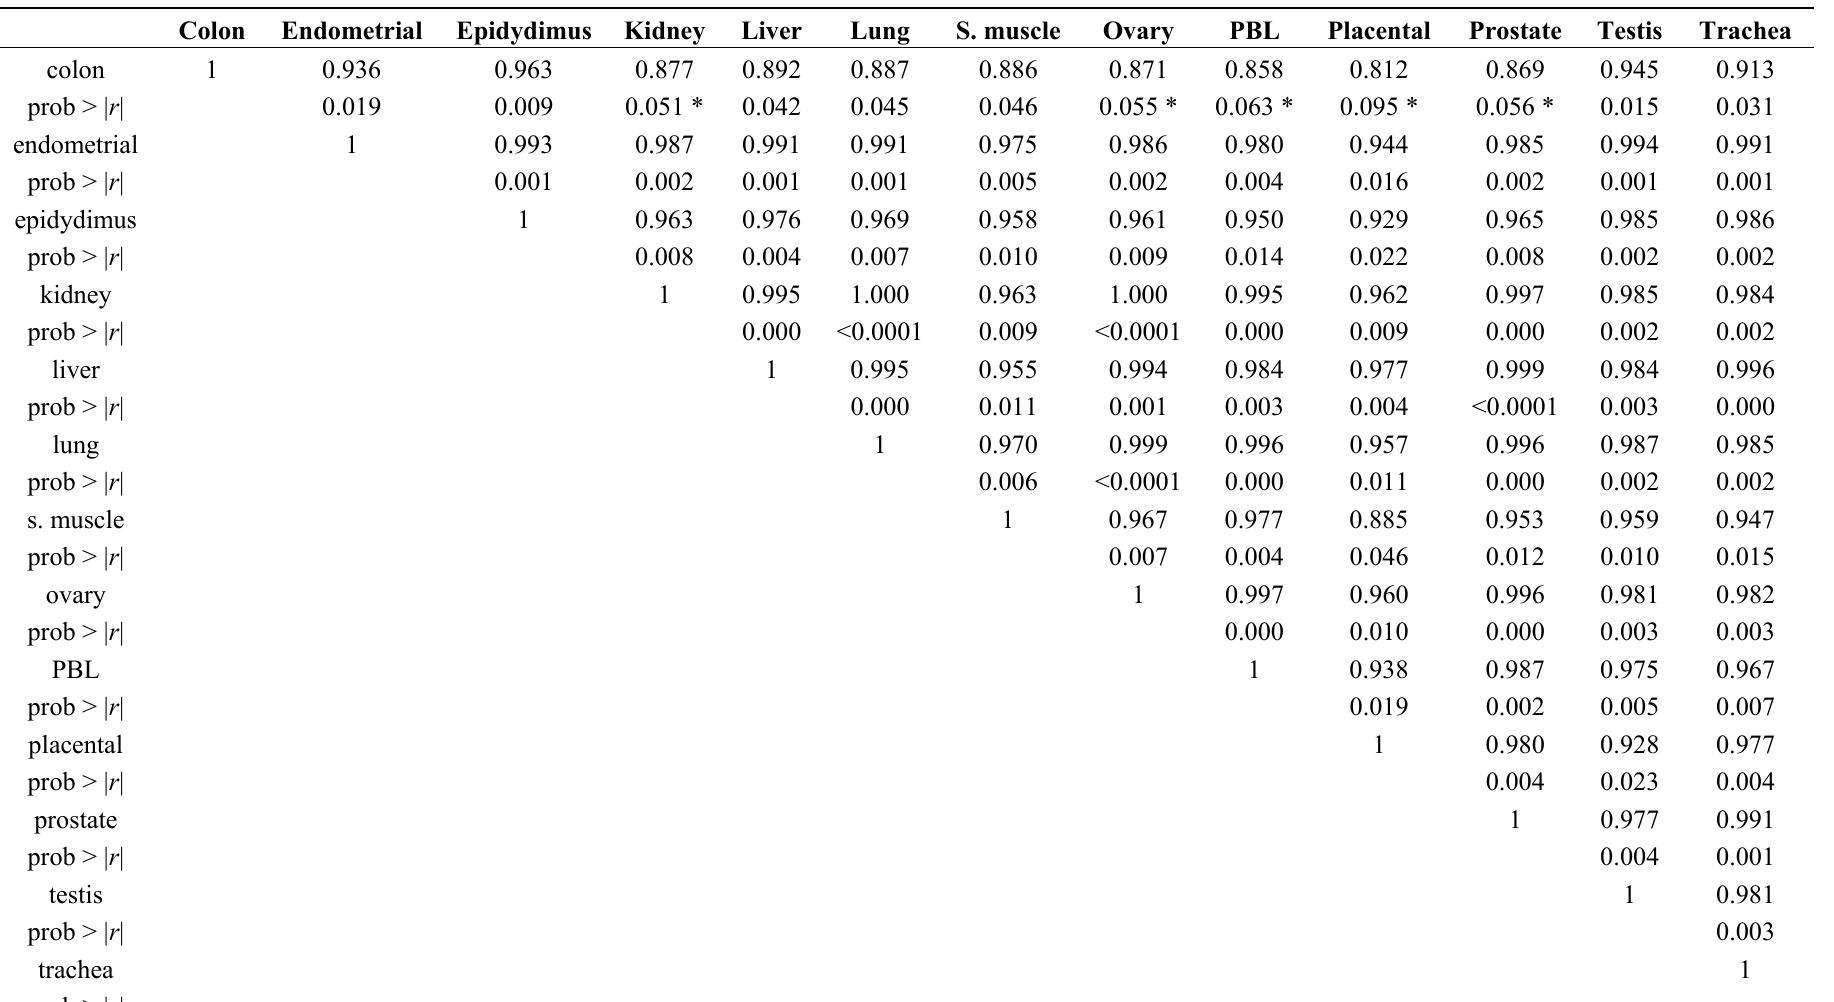
Table 3. Correlation analysis of HE4 splicing variants among normal tissues. There was a significant correlation between the HE4 variant expression patterns among the all the normal tissues except for Colon ( r > 0.88, p < 0.05). The expression pattern in Colon was not associated with those of Ovary, Placenta, PBL, Prostate and Kidney (marked as